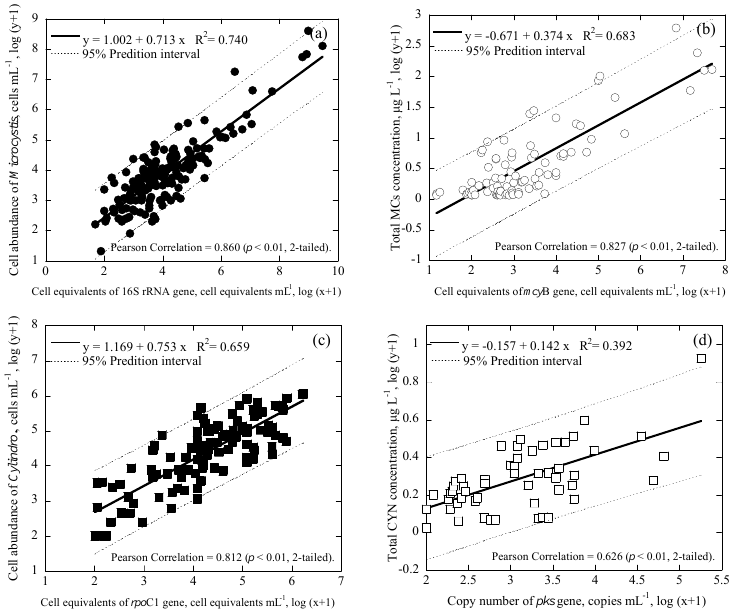
Figure 6. Correlation between cell enumeration, toxin concentrations, gene copies and cell equivalents for all the data with a 95% prediction interval (broken line), where ( a ) is for the cell enumeration of Microcystis using microscopy and cell equivalents of the 16S rRNA gene ( n = 173), ( b ) is for the total MCs concentration and cell equivalents of the mcy B gene ( n = 87), ( c ) is for the cell enumeration of Cylindropsermopsis using microscopy and the cell equivalents of rpo C1 gene ( n = 109), and ( d ) is for the total CYN concentration and copy number of pks gene ( n =